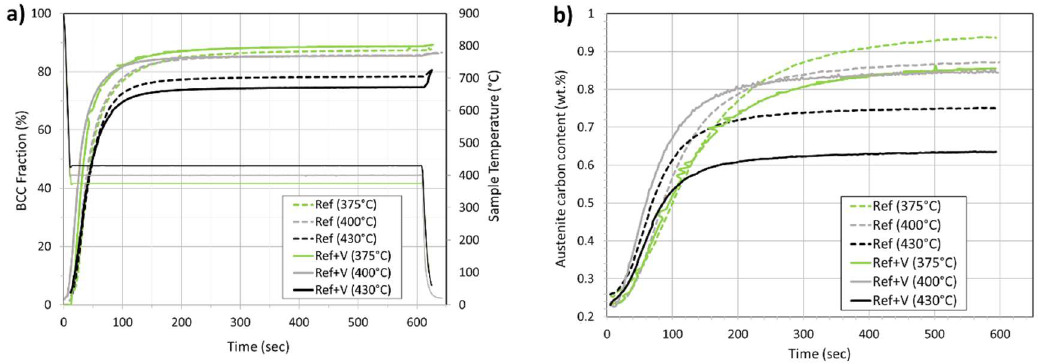
Figure 4. HEXRD data from Ref and Ref + V alloys as a function of the transformation temperature. ( a ) Body-centered cubic (bcc) phase fraction and ( b ) carbon content in austenite.